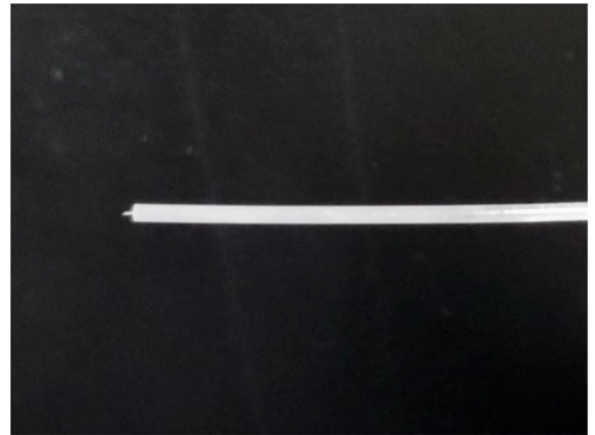
Figure 8. The crystalline fiber has been generated after annealing.